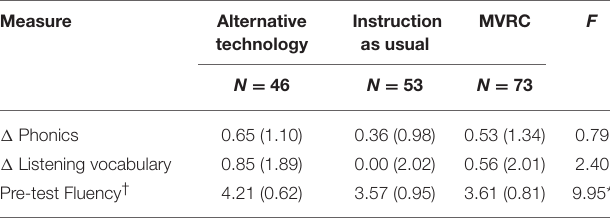
TABLE 6 | Averages Obtained for 4th-Graders from District 3, Separated by Condition.